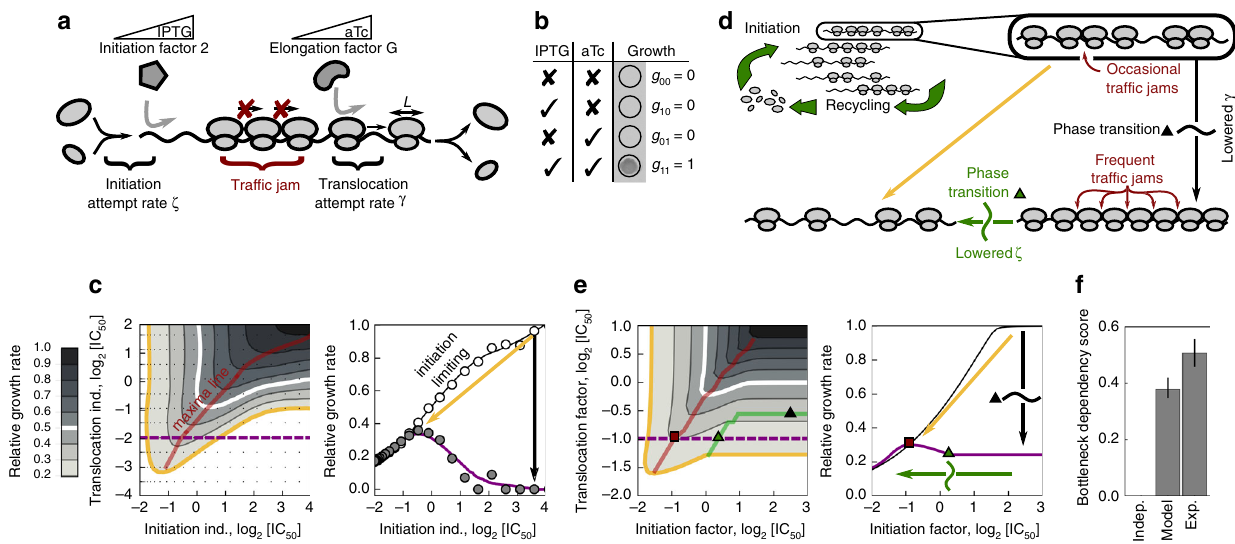
Fig. 6 Ribosome traf fi c jams underlie suppression between inhibition of translocation and initiation. a Schematic of ribosomes progressing along a transcript — a stuck ribosome can cause a traf fi c jam. Ribosomes undergo factor-mediated initiation events with attempt rate ζ and translocation with attempt rate γ . Expression of initiation and elongation factors are controlled by the level of inducer (IPTG and aTc, respectively). b Results of all-or-nothing growth assay: bacteria grow only when both essential factors are induced. c Left: measured growth rate response surface for the dual inducible promoter strain from ( a ) as a function of both inducer concentrations; the red line shows the ridge of maximum growth. Right: cross-section of the response surface along the dashed purple line (gray circles) and at maximal aTc induction (white circles); solid lines are smoothed pro fi les. Black arrow denotes a decrease in translocation; if initiation is lowered simultaneously with translocation (orange arrow), growth reduction is smaller. d Schematic of the theoretical model: translation is described as an ensemble of transcripts competing for the limited and growth-rate-dependent pool of ribosomes. Ribosomes advance on transcripts as described by a generalized totally asymmetric simple exclusion process (TASEP) for particles of size L (see a and text). When γ < ζ (1 + L 1/2 ), ribosomes saturate and traf fi c jams develop, resulting in a drop in elongation and growth (black arrow, the transition happens at the black triangle) (Supplementary Methods 59,60 ,). When ζ < γ /(1 + L 1/2 ), a phase transition occurs (green triangle): traf fi c jams dissolve — elongation and growth increase (along the green arrow). e Left: the growth rate predicted by the generalized TASEP model recapitulates suppression of translocation inhibition by lowered initiation; note that, unlike in ( c ), axes show the concentrations of translation factors. States below and to the right of the green line are in the translocation limiting regime. Right: cross-sections of the response surface. As the initiation factor level is decreased, the critical point of the phase transition (green triangle) is reached; growth starts increasing after passing the critical point, and decreases again after passing the maximum (red square) as the number of translating ribosomes becomes limiting. f Bottleneck dependency (BD) score quanti fi es the deviation from independent expectation (BD = 0) for the response surfaces in ( c , e ); heights of bars corresponds to the medians and error bars are 90% bootstrap con fi dence intervals. Medians and con fi dence intervals were estimated from n = 100 bootstrap data